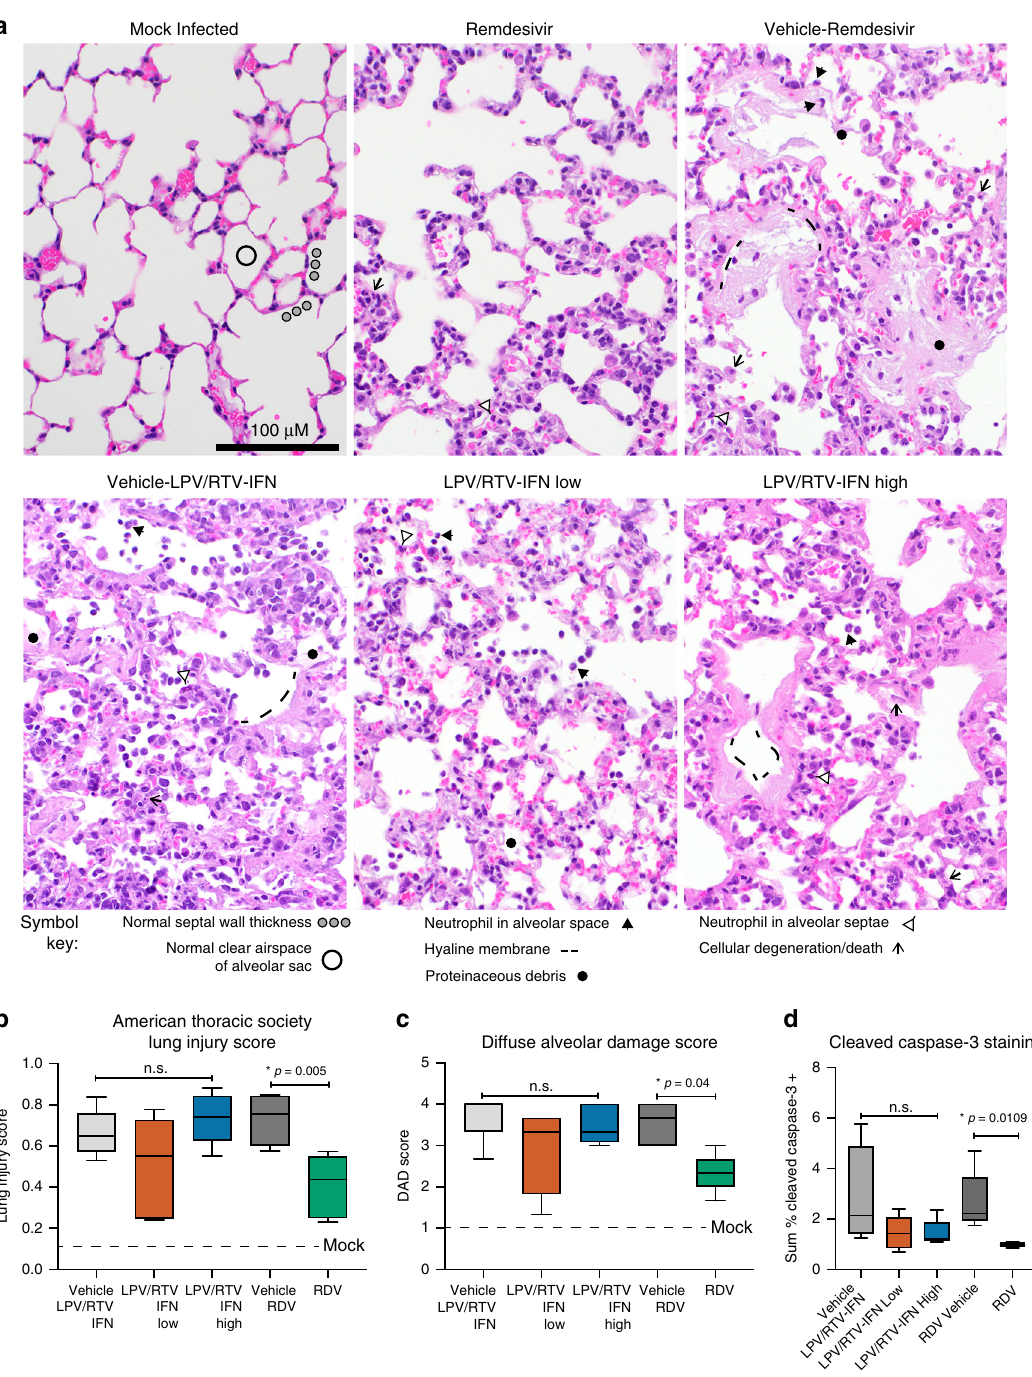
Fig. 7 Therapeutic RDV but not LPV/RTV-IFNb diminishes signs of ALI. a Representative images of the histological features of acute lung injury 6 dpi comparing a mock-infected mouse to the therapeutic treatment groups described in Figs. 5 and 6. Symbols identifying example features of disease are indicated in the fi gure. b American Thoracic Society Lung Injury Score derived as described in Fig. 3. The numbers of animals per group quantitated: vehicle RDV N = 7, RDV N = 7, vehicle LPV/RTV-IFNb N = 9, LPV/RTV-IFNb low N = 7, LPV/RTV-IFNb high N = 8. c Diffuse alveolar damage score quantitating the degree of cellular sloughing, necrosis, and breakdown of barrier epithelium and vascular leakage. For both b and c , scores were blindly assessed in three random high power (×60) fi elds of diseased lung tissue sections. d Quantitation of cleaved caspase-3 antigen staining in lung tissue sections from studies described in Figs. 5 – 7. Cleaved caspase-3 is a marker of cell death. The numbers of animals per group quantitated for all groups was N = 5/group. For the box and whisker plots, the boxes encompass the 25th to 75th percentile, the line is at the median, while the whiskers represent the range. For b – d , asterisks indicate statistical signi fi cance by one-way ANOVA and Kruskal – Wallis multiple comparison